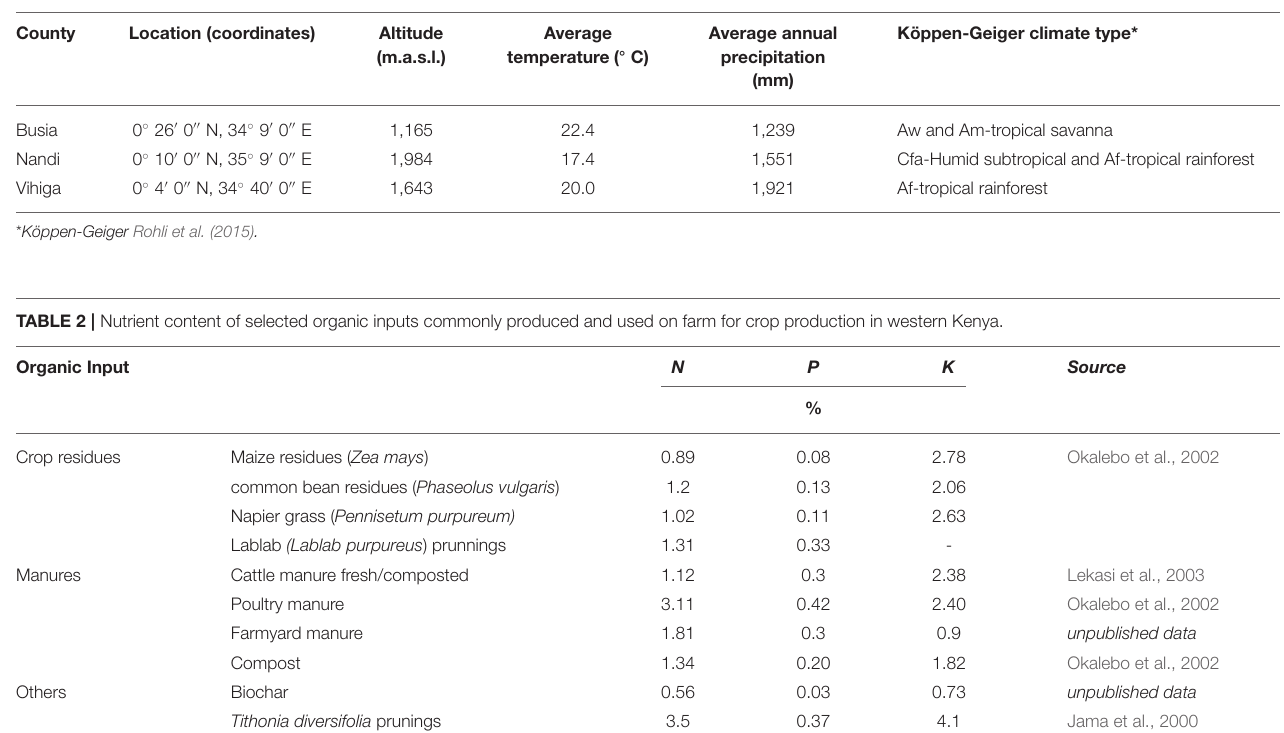
TABLE 1 | Climate and location data for three counties in western Kenya where farmers were surveyed to evaluate allocation of organic nutrient sources in smallholder farming communities. County Location (coordinates)